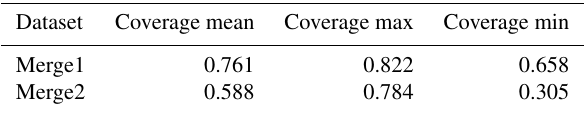
Table 2. Mean, max, and min of monthly global coverage between 1900 and 2001 and between 2017 and 2012. Dataset Coverage mean Coverage max Coverage min Merge1 0.761 0.822 0.658 Merge2 0.588 0.784